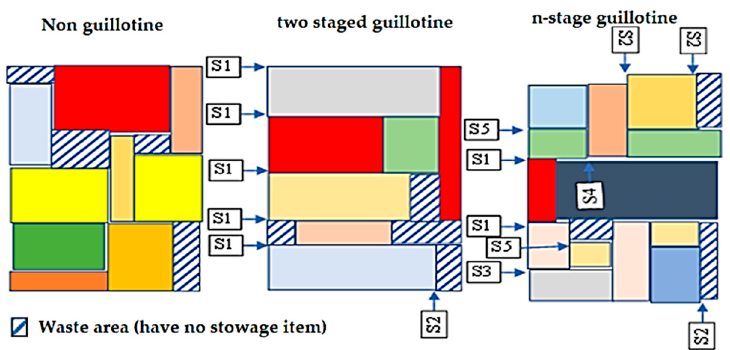
Figure 3. The ant plan stowing layout methods.